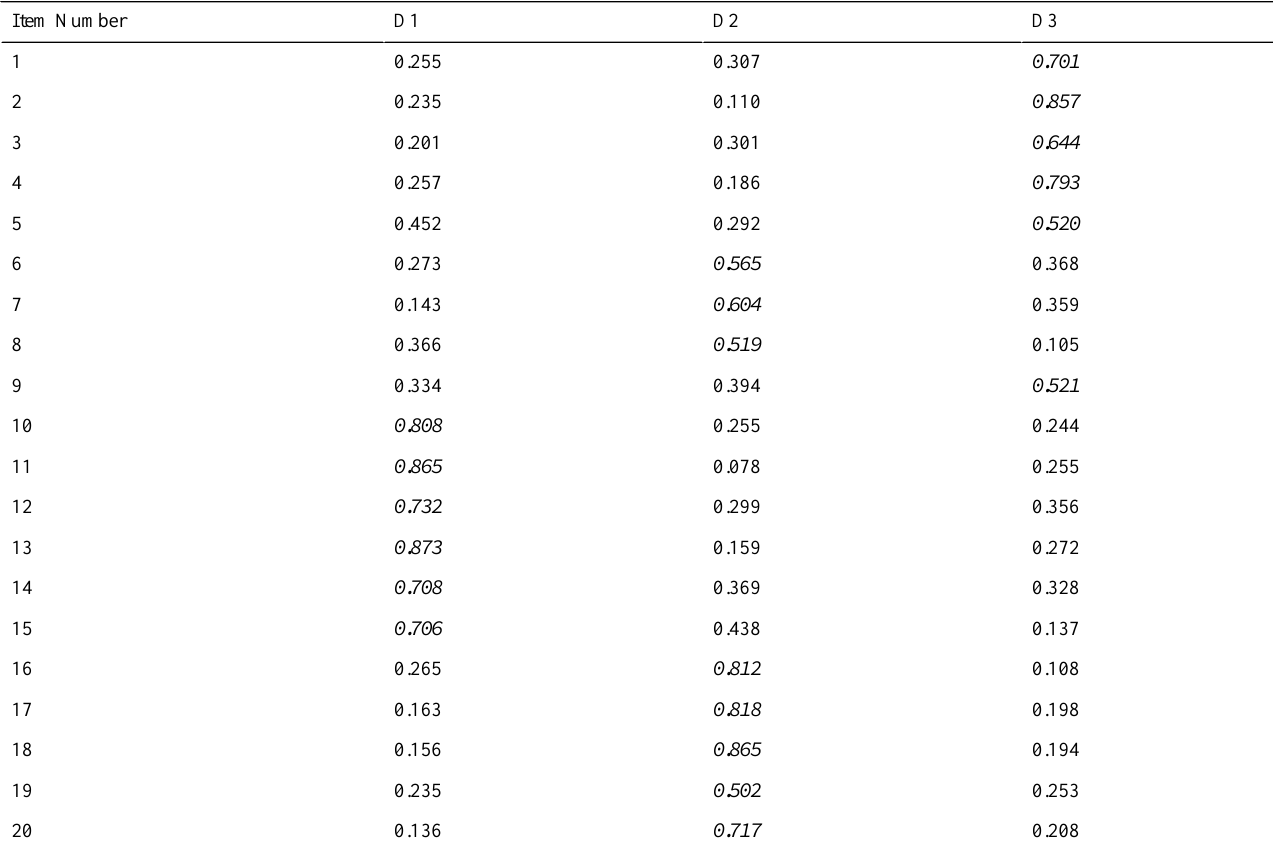
Table 2. Factor loading of the Nomophobia Questionnaire. Salient factor loadings are indicated in